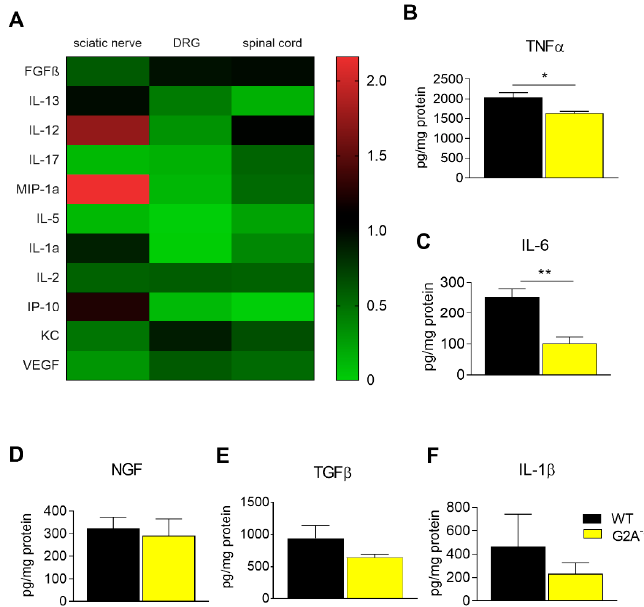
Figure 3. Reduced concentrations of inflammatory cytokines in G2A-deficient mice. ( A ) Heat map of cytokines levels in sciatic nerve, DRG and spinal cord at the ipsilateral site of wild-type and G2A- deficient mice 7 days after SNI. Data shown as ipsi-lateral of WT vs. ipsi-lateral of G2A-defcient mice measured with LUMINEX. ( B – F ) Concentrations of tumor necrosis factor α (TNF α ) ( B ), interleukin 6 (IL-6) ( C ), nerve growth factor (NGF) ( D ), transforming growth factor β (TGF β ) ( E ) and IL-1 β ( F ) in the ipsilateral site of sciatic nerve 7 days after SNI in wild-type (WT, black) and G2A-deficient mice (G2A − / − , yellow in sciatic nerve), measured with enzyme-linked immunosorbent assay (ELISA). Data represent mean ± SEM. * p < 0.05, ** p < 0.01, *** p < 0.005, **** p < 0.001 of n = 5 mice per group, male and female; one-way ANOVA.